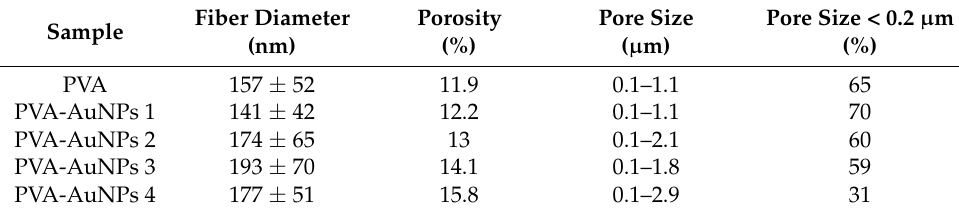
Table 3. Summary of the electrospun membrane’s morphological